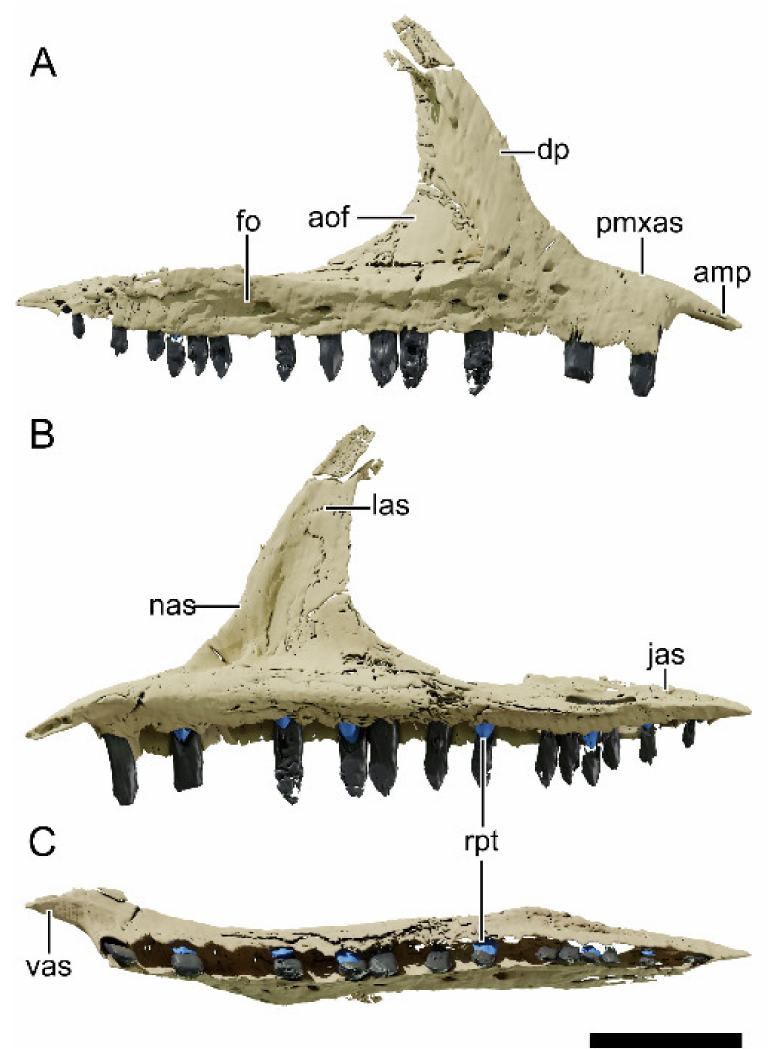
Figure 11. Digital reconstruction of the right maxilla of NHMD 164758. ( A ) Lateral view. ( B ) Medial view. ( C ) Ventral view. Abbreviations: amp, anteromedial process; aof, antorbital fossa; dp, dorsal process; fo, foramen; jas, articular surface for the jugal; las, articular surface for the lacrimal; nas, articular surface for the nasal; pmxas, articular surface for the premaxilla; rpt, replacement tooth; vas, articular surface for the vomer. Scale bar = 20